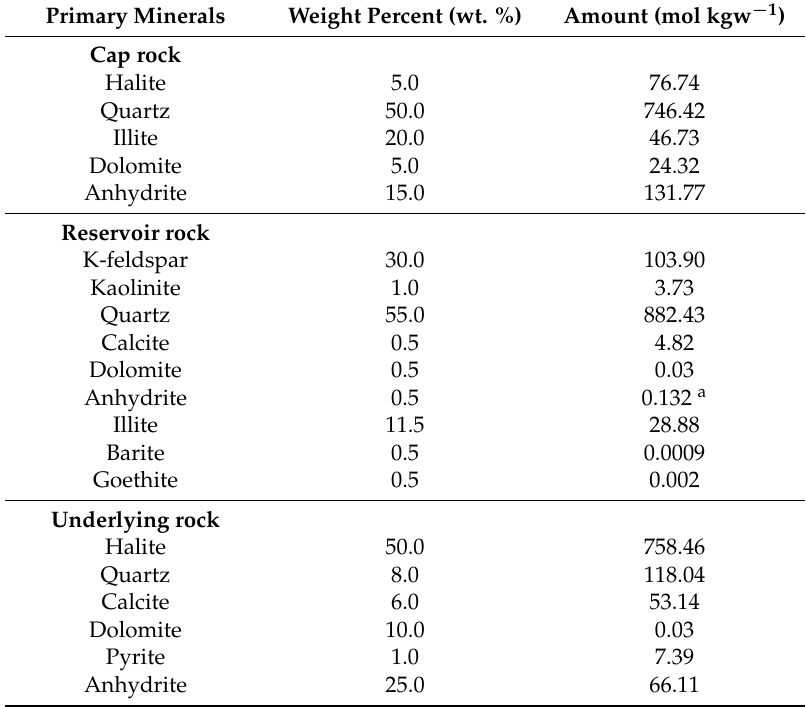
Table 2. Mineralogical composition of the reservoir rock, cap rock, and underlying rock. Dawsonite, nahcolite, mackinawite, sulfur, albite (and pyrite) are potential secondary phases. Primary Minerals Weight Percent (wt.